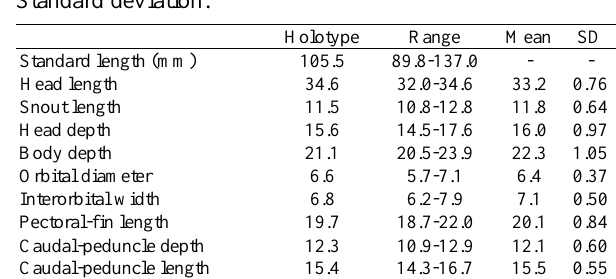
Table 1. Proportional measurements in percents of standard length of holotype and 16 paratypes of Crenicichla ypo . SD = Standard